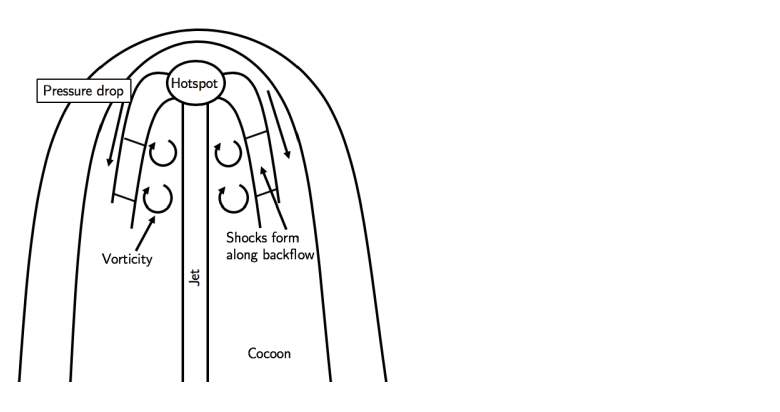
Figure 18. Sketch of the considered scenario, where multiple (mildly relativistic) shocks in fast back- flows surrounding the large-scale jets of radio galaxies are considered to provide sites for efficient UHECR acceleration. From ref.